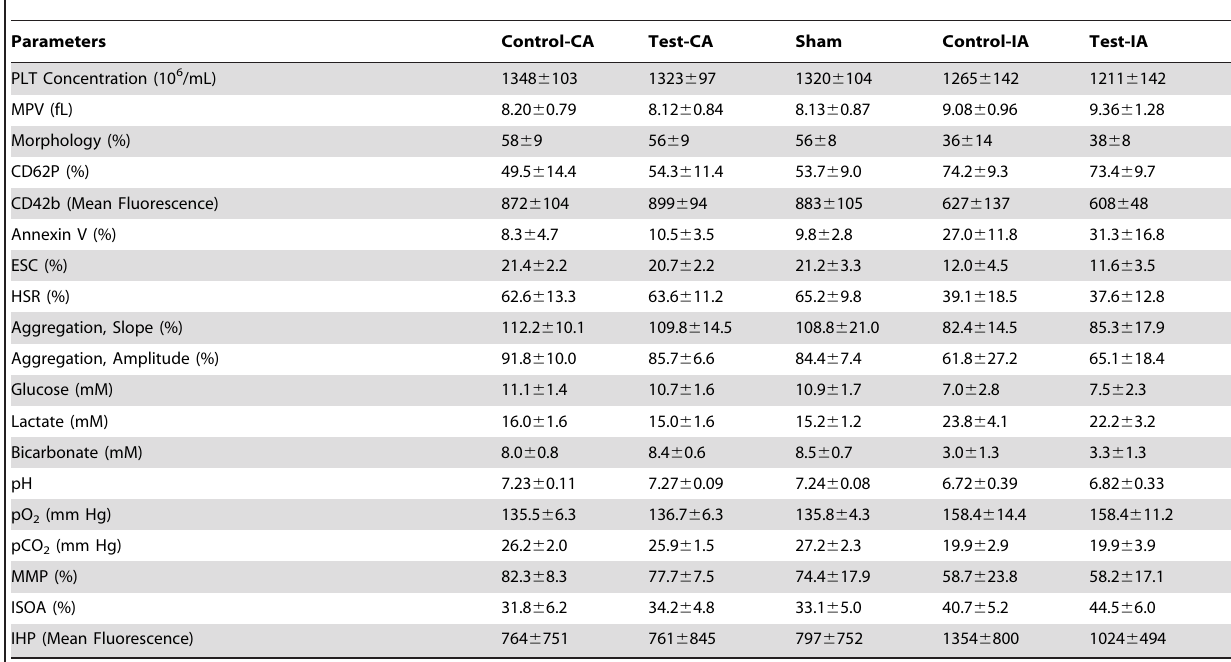
Table 2. PLT parameters assessed on Day 7 of storage with continuous and interrupted agitation with or without ERK MAPK inhibitor,